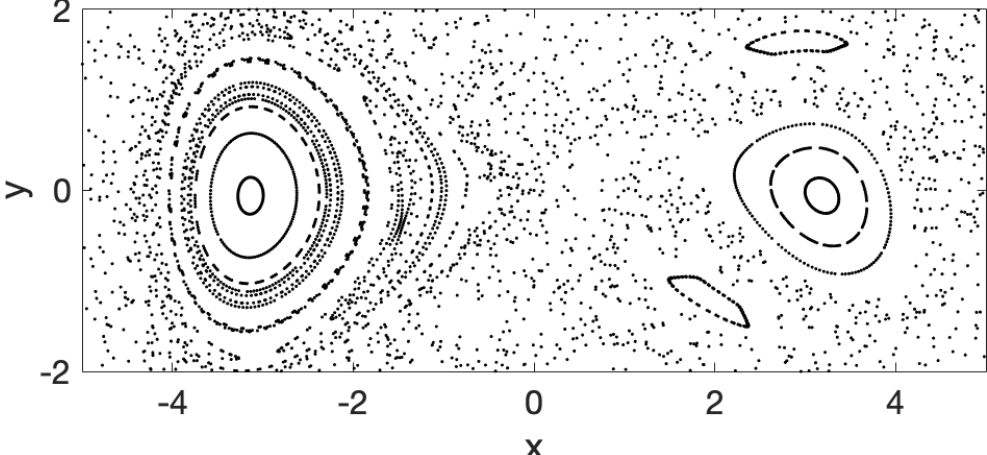
Figure A7. Poincaré map for a second example of the asymmetric Duffing oscillator with 100 periods of perturbation T pert .